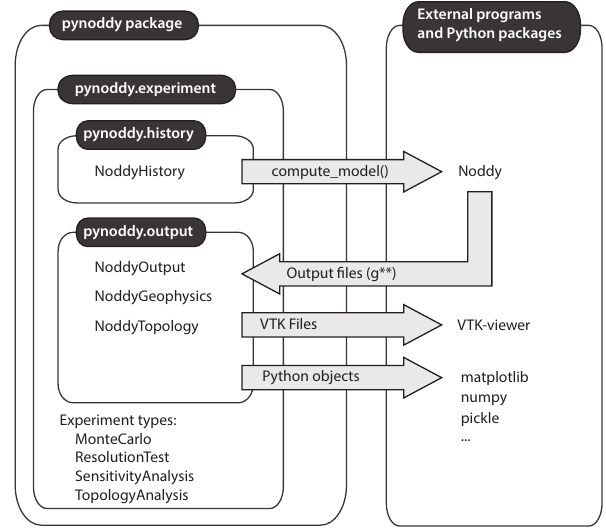
Figure 2. High-level structure of main pynoddy modules and re- lationship to command-line application Noddy and other python packages. Important to note is the concept of high-level classes, defined in the module pynoddy.experiments , to encapsulate history file and output